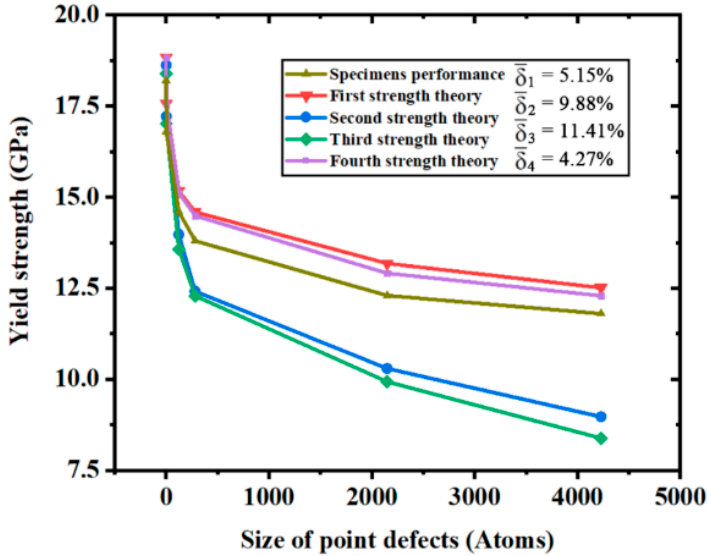
Figure 7. Theoretical strength given by four theories of strength compared with actual specimen performance.